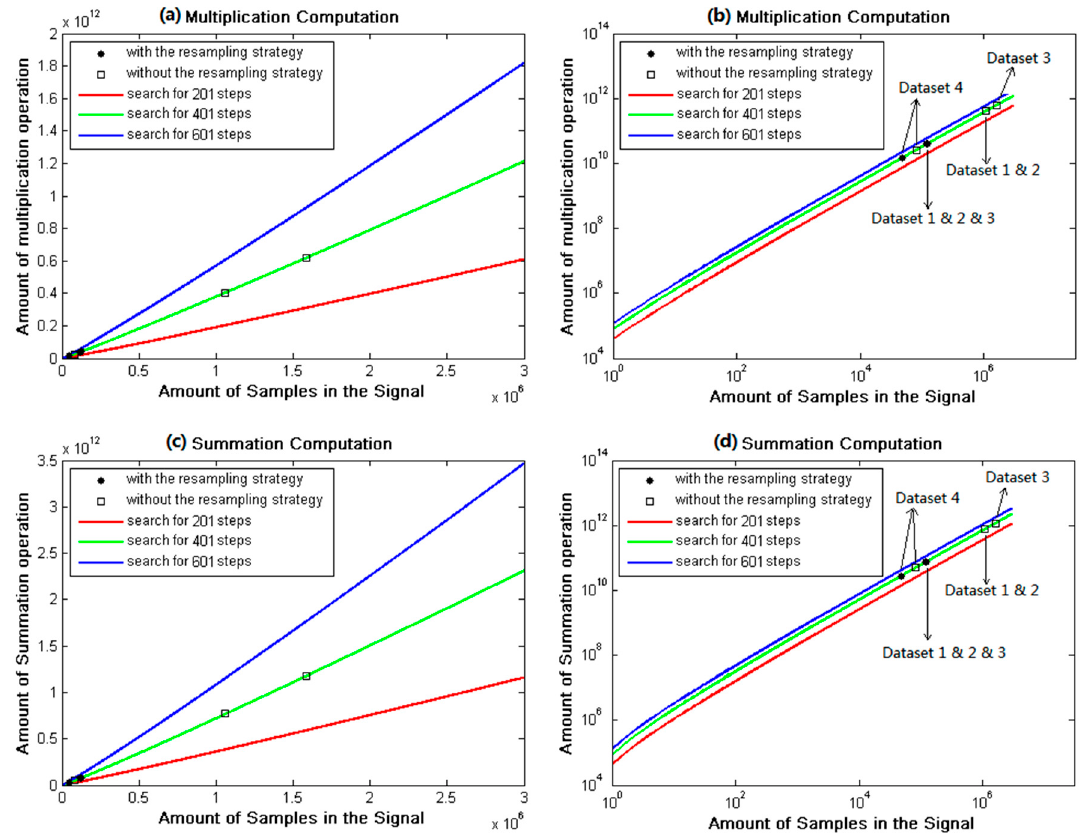
Figure 11. Computation of signal acquisition without/with the resampling strategy for all experimental datasets: ( a ) Multiplication computation in linear axis; ( b ) Multiplication computation in log axis; ( c ) Summation computation in linear axis; ( d ) Summation computation in log axis.